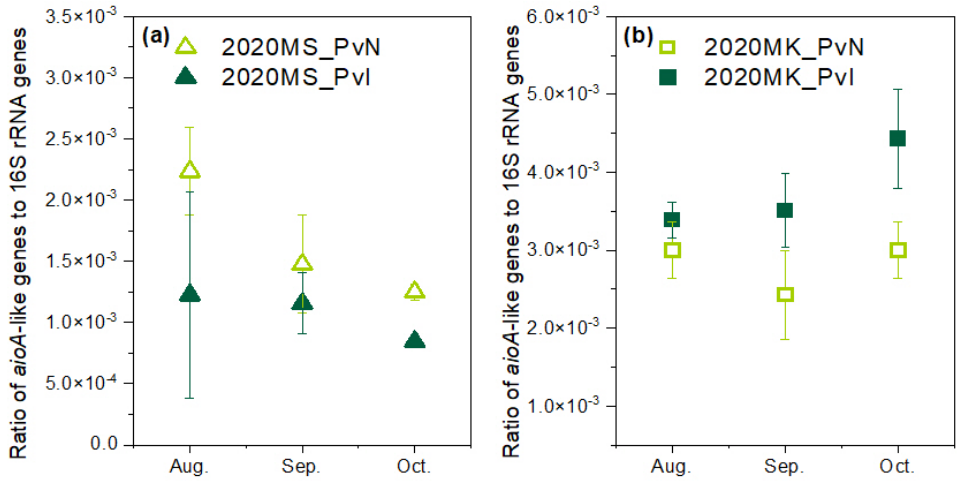
Figure 5. Copy ratio of aioA -like genes to 16S rRNA genes in the rhizosphere of P. vittata ( a ) 2020 in site MS and ( b ) 2020 in site MK.